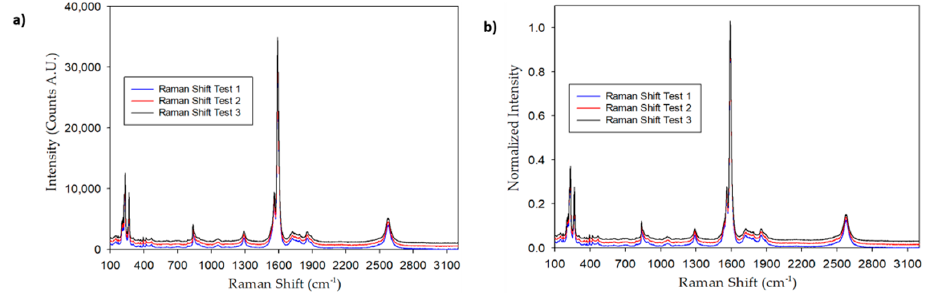
Figure 1. Raman spectroscopy at 785 nm beam of a BP at three different spots, with a 500-count displacement between each ( a ); normalized graphs, each with a 0.015-normalized intensity displacement ( b ). Using the average Radial Breathing Mode (RBM) peaks from Figure 2, a 0.98 nm diameter was calculated with Equation (1) and the published values [10] for the A and B constants (A = 234 nm/cm, B = 10 cm − 1 for SWCNT) that depend on the number of CNT layers and tube–tube interactions.